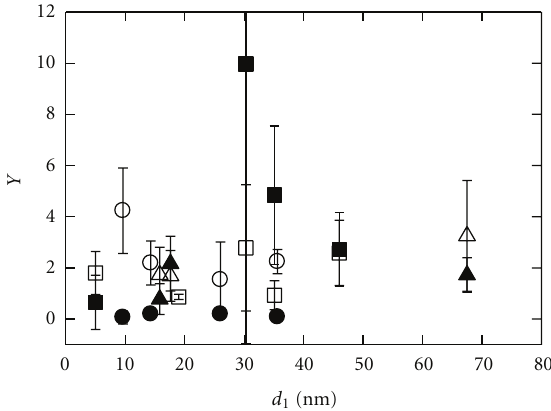
Figure 7: Normalized specific growth ( R s ) for three particle- types. Circles are SiO 2, triangles are Al 2 O 3 , and squares are TiO 2 . Open symbols are 100 mg/L of exposure dosage. Solid symbols are 1000 mg/L of exposure dosage. Experimental conditions: initial algae concentration = 1 . 4 ± 0 . 9 × 10 6 cell/mL, test duration = 4 days, and initial test volume = 200 mL.